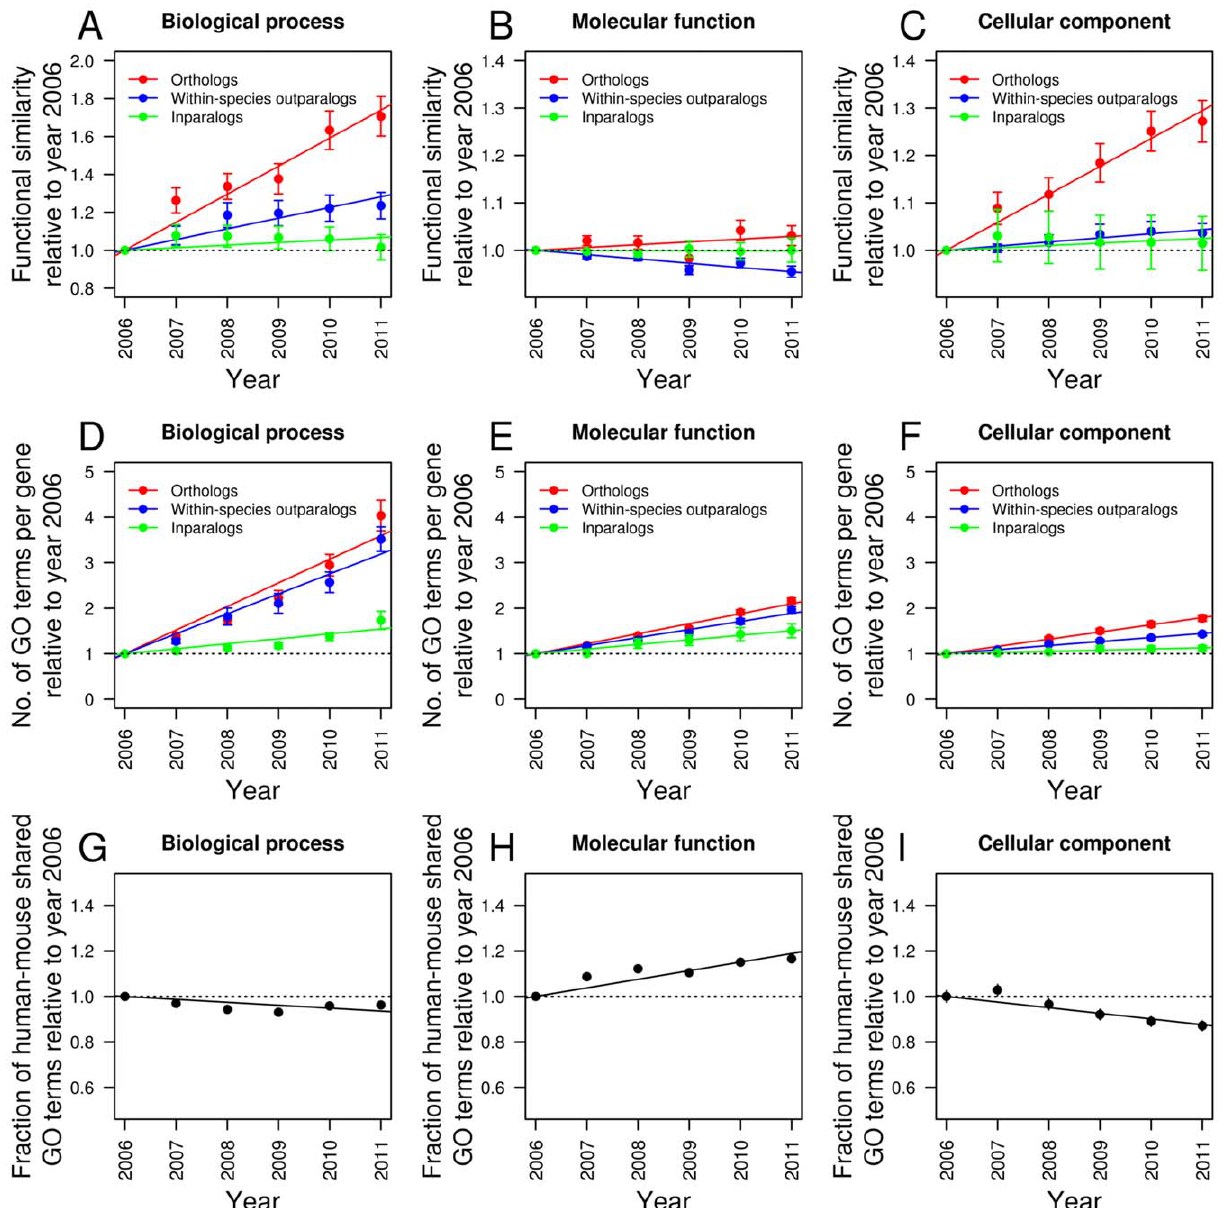
Figure 1. GO-based functional similarities of orthologs and paralogs vary in the last five years. ( A – C ) Functional similarities estimated from the GO annotations of different years, relative to those in 2006. In each of (A)–(C), the slopes of the three regression lines are significantly different from one another ( P , 0.02, two-tail Z -test), with the exception of the comparison between outparalogs and inparalogs in (C), which has a P - value of 0.08. ( D – F ) Numbers of GO annotations per gene in different years, relative to those in 2006. In each of (D)–(F), the slopes of the three regression lines are significant ( P , 0.002, two-tail t -test) and are significantly different from one another ( P , 0.0003, two-tail Z -test), with the exception of the comparison between outparalogs and orthologs in (D), which has a P -value of 0.09. ( G – I ) Fractions of shared GO terms between human and mouse in different years, relative to year 2006. The fraction is calculated by the number of overlapping GO terms divided by the total number of unique GO terms in human and mouse GO annotations. In each of (G)–(I), the slopes of the three regression lines are significantly different from 0 ( P , 0.012, two-tail t -test). In all panels, error bars indicate one standard error, although in some panels they are barely visible.